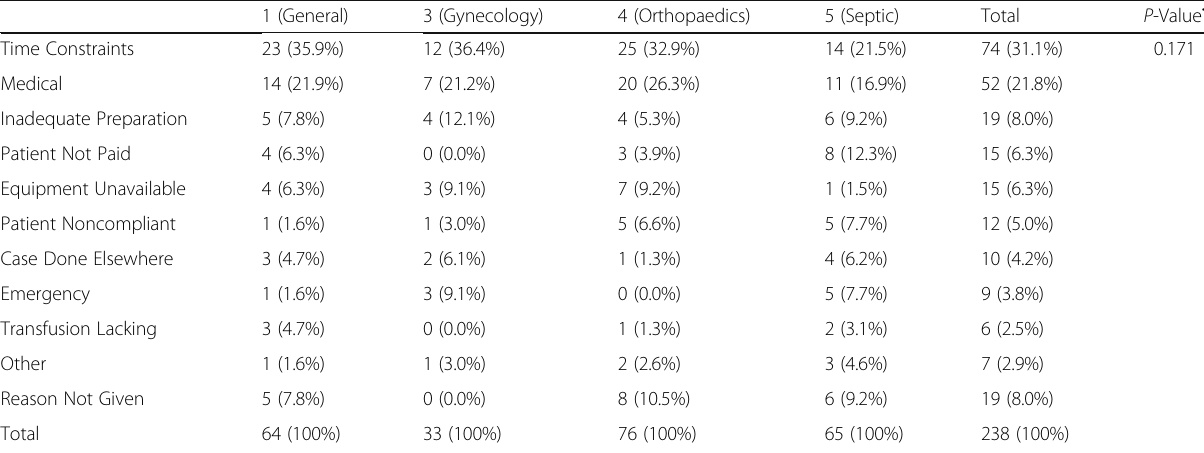
Table 6 Number of cancellations by elective theater